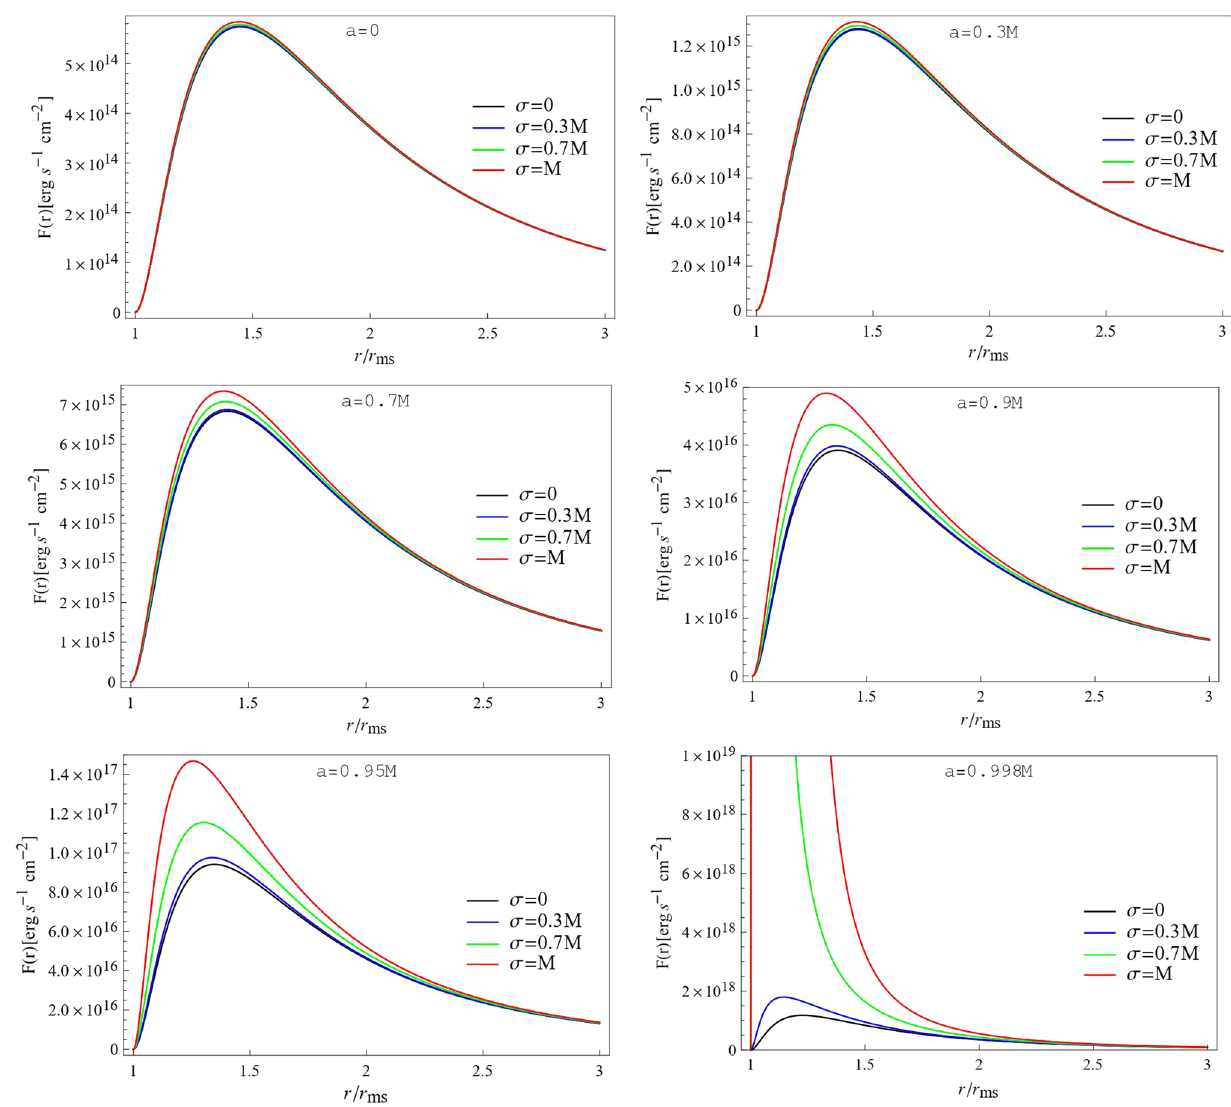
Fig. 1 Variation of radiative flux with distances away from r